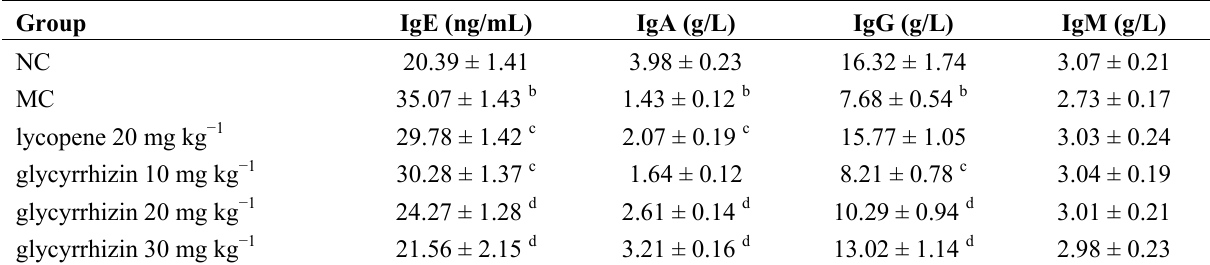
Table 2. Effect of glycyrrhizin treatment on blood IgE, IgA, IgG and IgM levels. Group IgE (ng/mL) IgA (g/L) IgG (g/L) IgM (g/L)